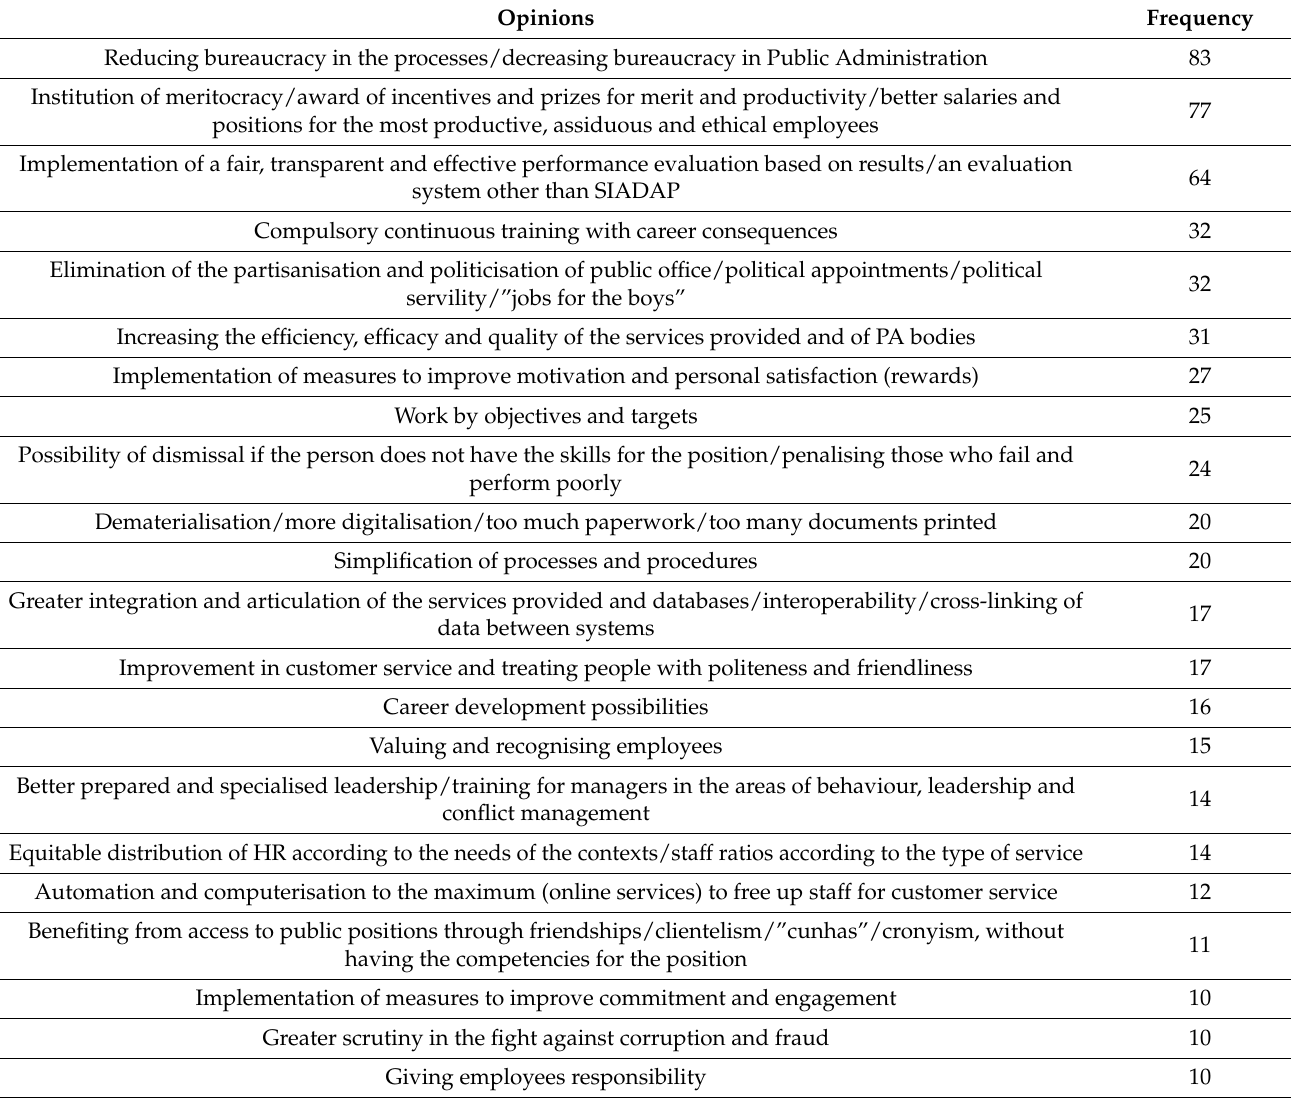
Table 9. Frequency analysis of opinions of the question “What would you change in the PA?”. Opinions